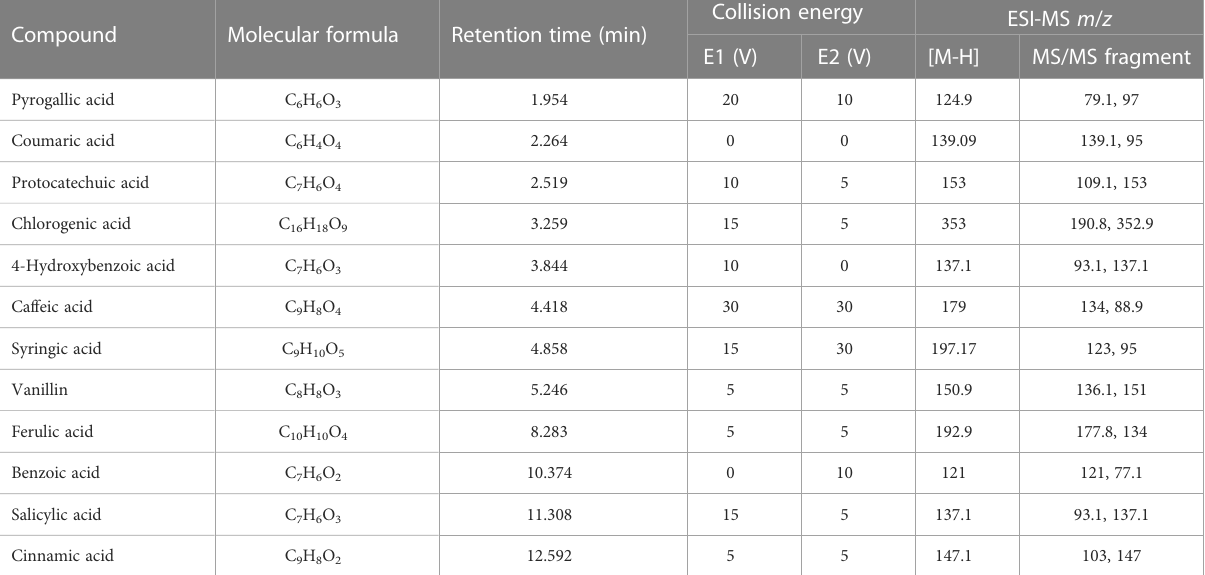
TABLE 1 LC-ESI-QQQ-MS/MS analysis of these phenolic acids.